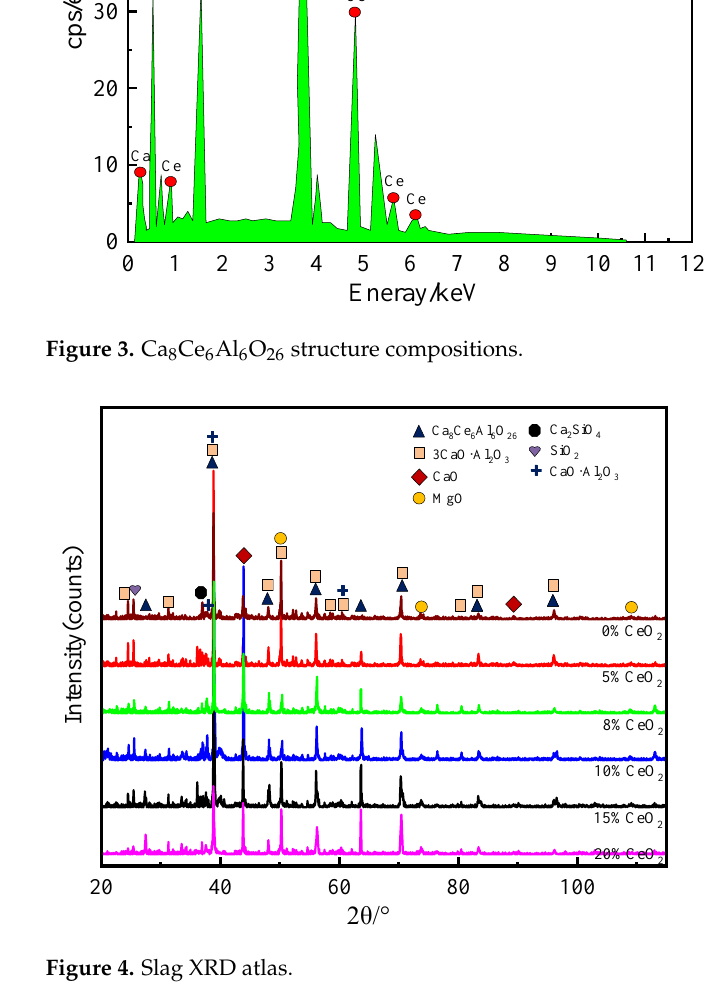
Figure 4. Slag XRD atlas.